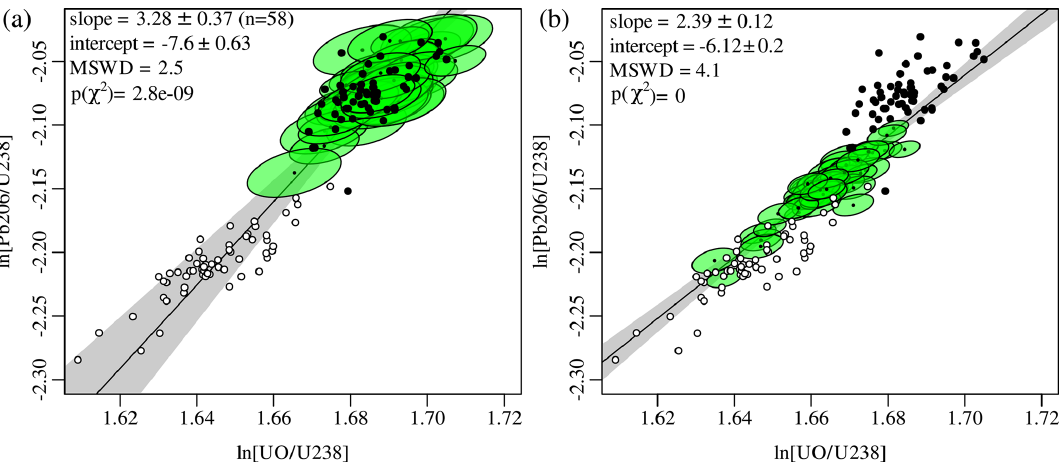
Figure 6. (a) U–Pb calibration curve for the Temora2 SHRIMP data using the time-zero ( τ = 0) intercepts (green ellipses). Black and white dots mark the first and last cycles of each analysis, respectively. (b) The log-ratio data and calibration fit for the same data, but evaluated at the midpoint ( τ = 544), resulting in a more precise calibration. All uncertainties are shown at 95%